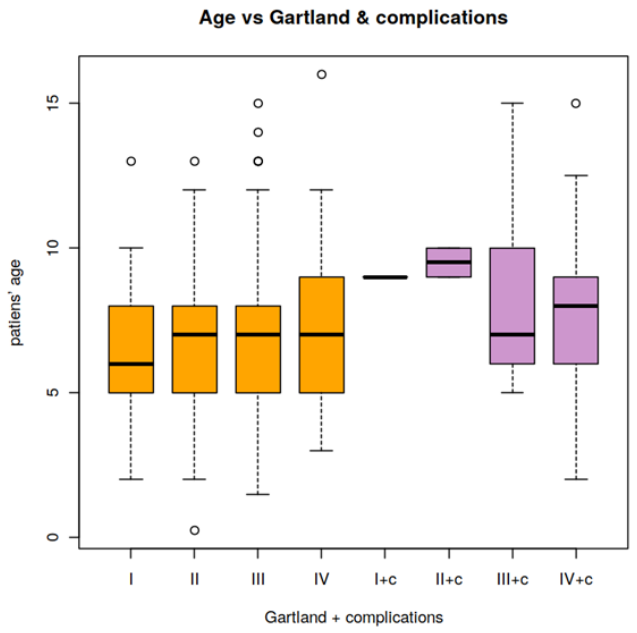
Figure 2. Ages of patients without (orange) and with (purple) neurovascular lesions by Gartland type. c, complications.